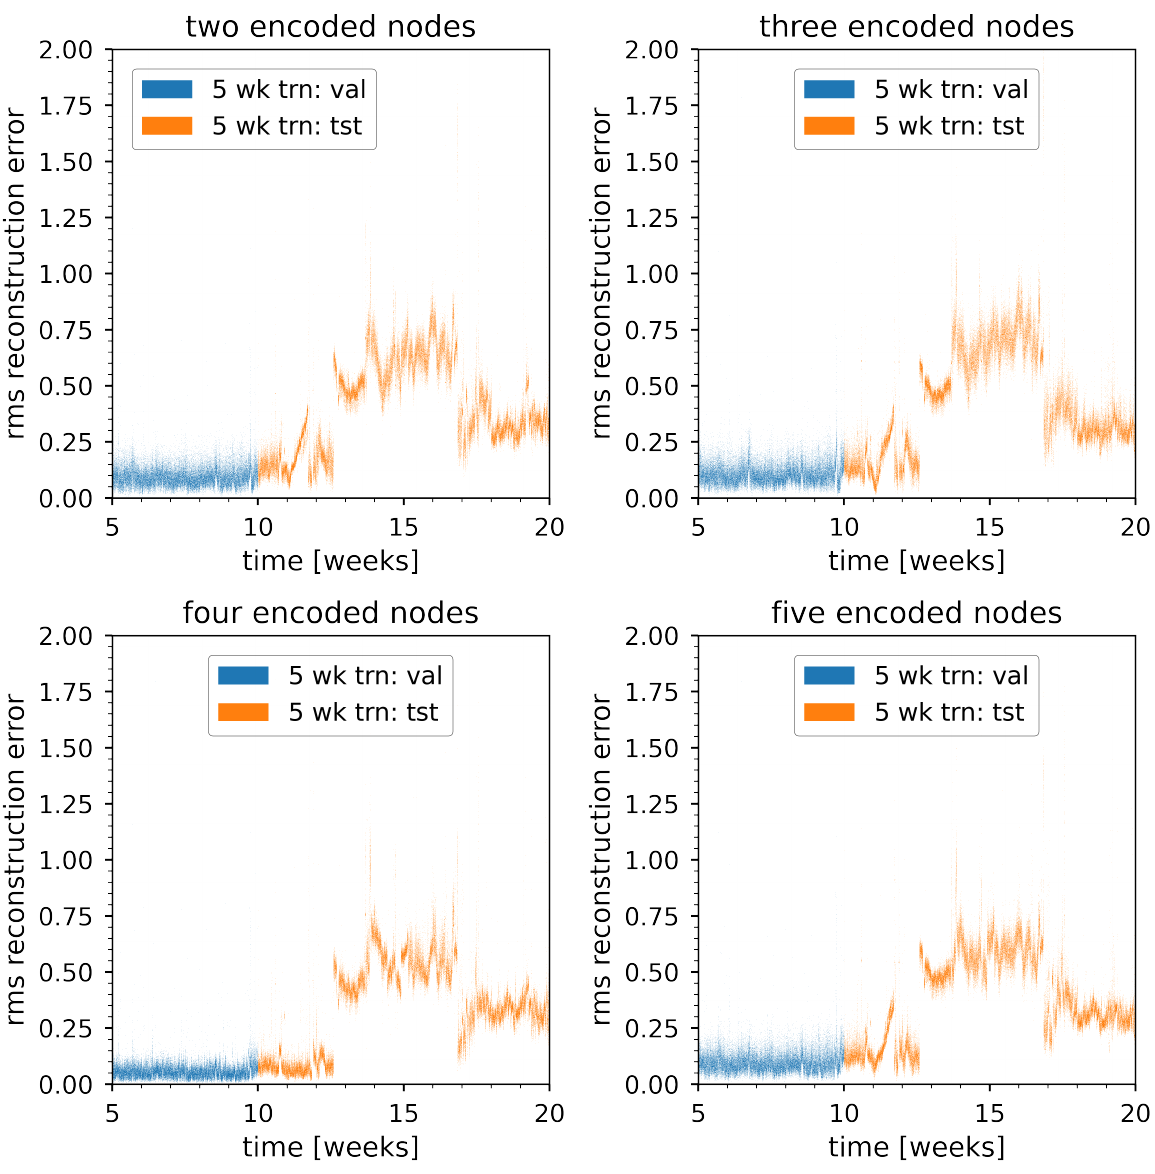
Figure 14. Root Mean Squared (RMS) reconstruction error as a function of time for the autoencoder trained on data from weeks 5 to 10 and tested on weeks 10 to